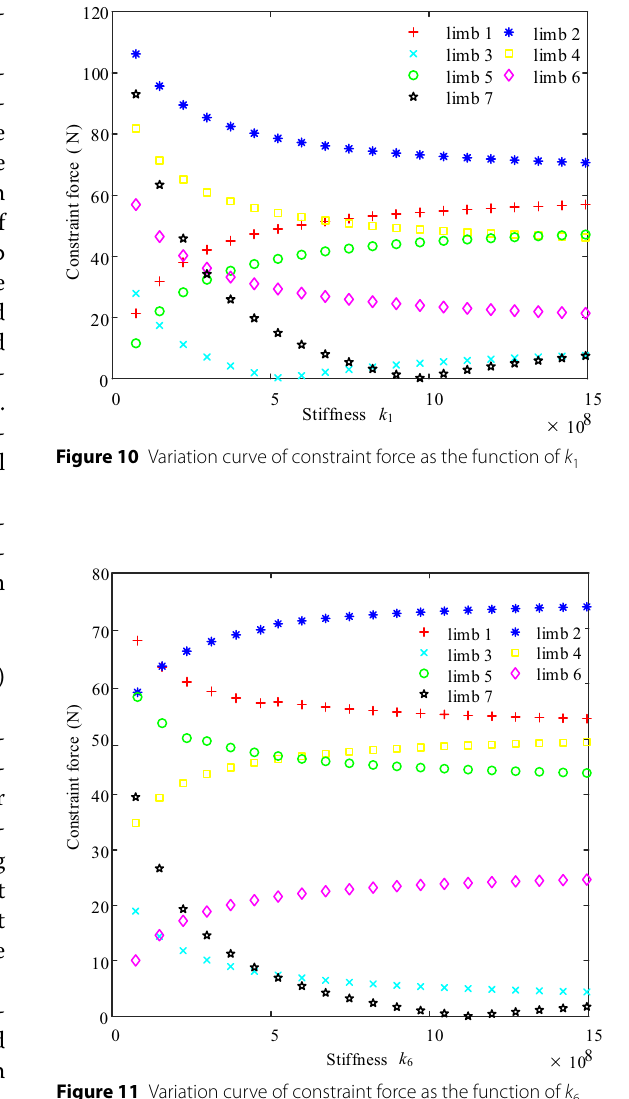
Figure 11 Variation curve of constraint force as the function of k